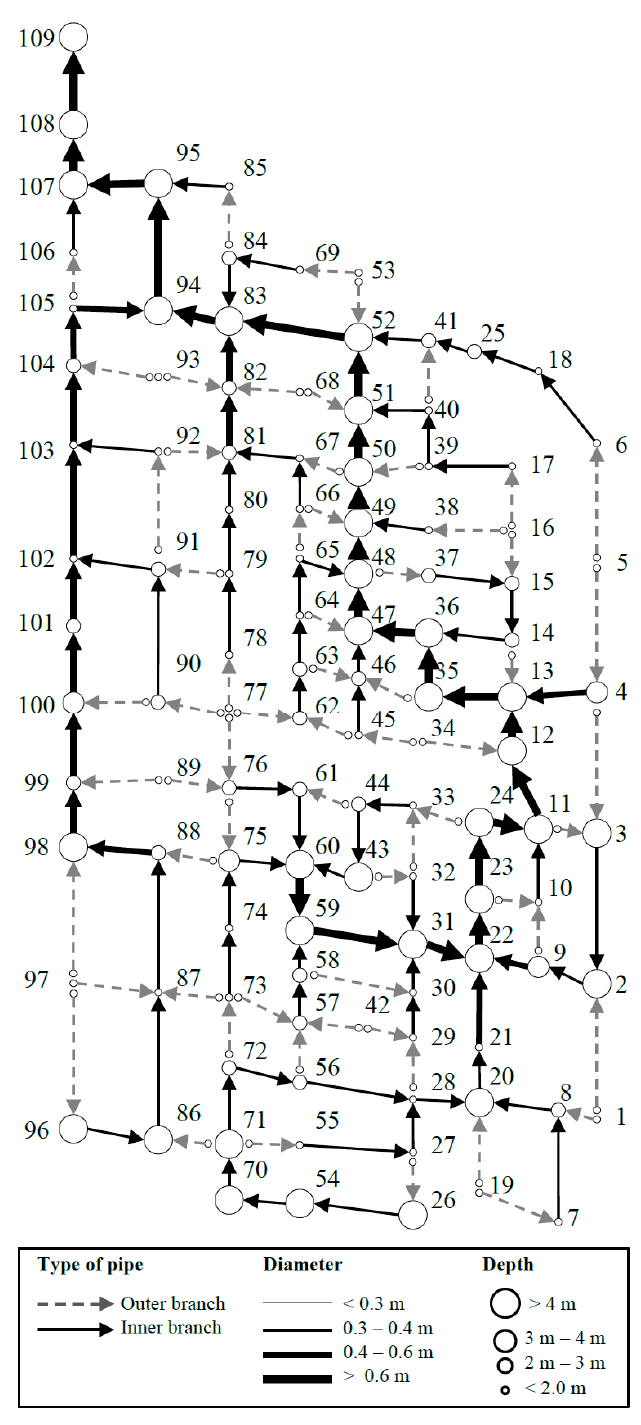
Figure 7. Layout and hydraulic design of Chicó sewer network.